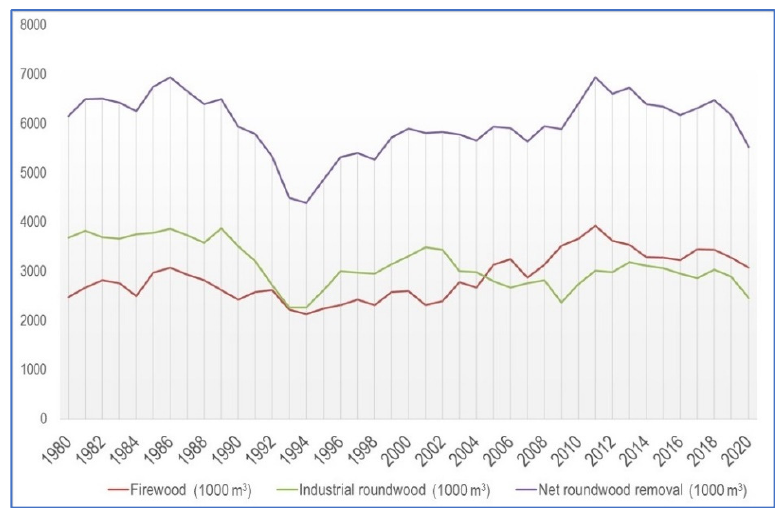
Figure 1. Amount of wood removal and slash in time period of 1980–2020.